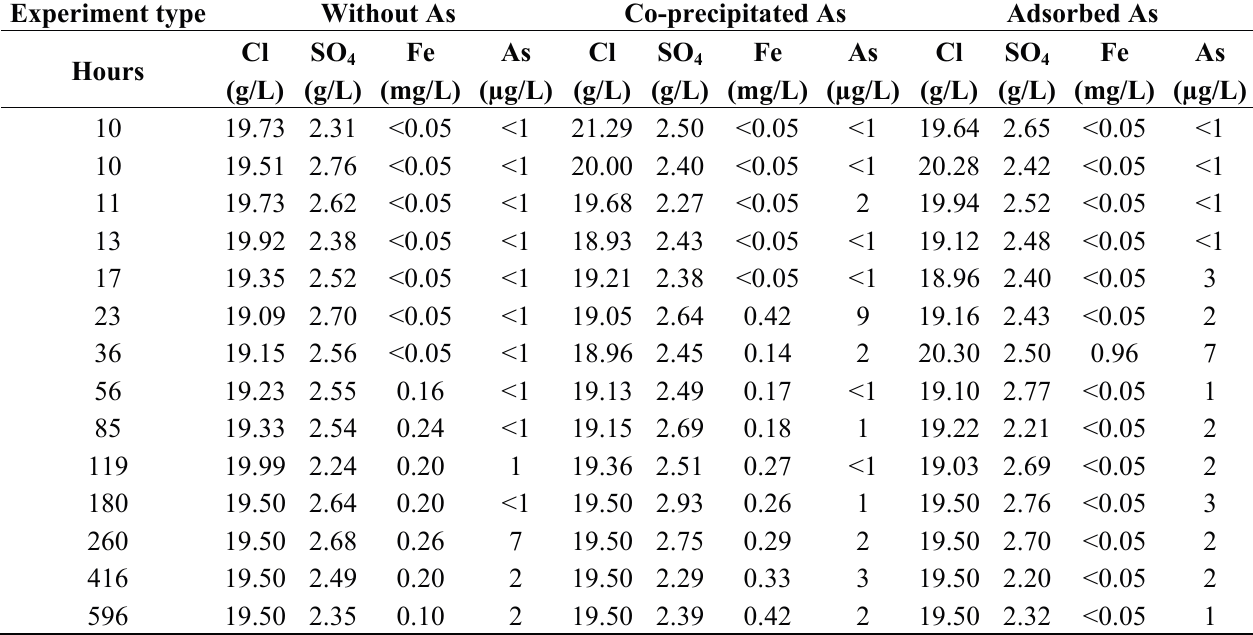
Table 4. As release from